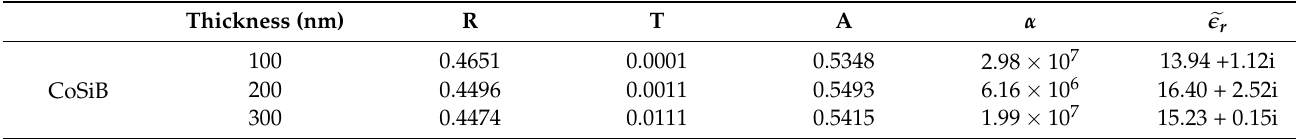
Table 2. Estimated optical properties of CoSiB amorphous thin films at 632.8 nm.